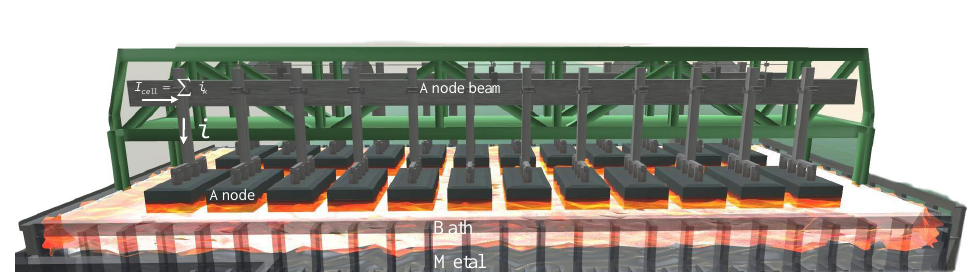
Figure 12. Structural schematic diagram of aluminum electrolysis